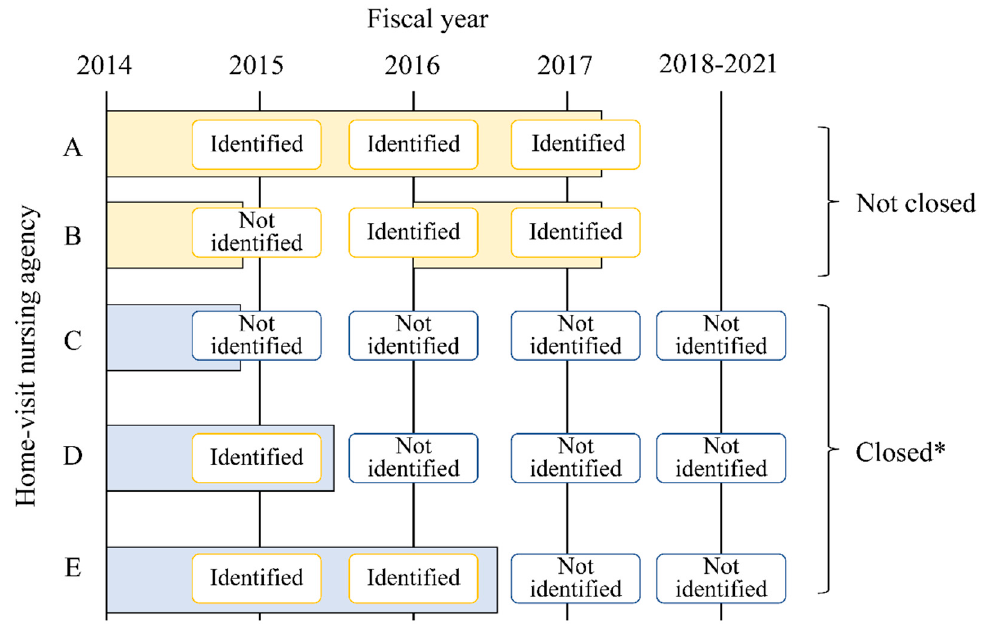
Figure 2. Identifying closed home-visit nursing agencies. * We confirmed whether their information appeared in more recently published datasets using information from the LTC-DB published online in 2018, 2019, and 2020.